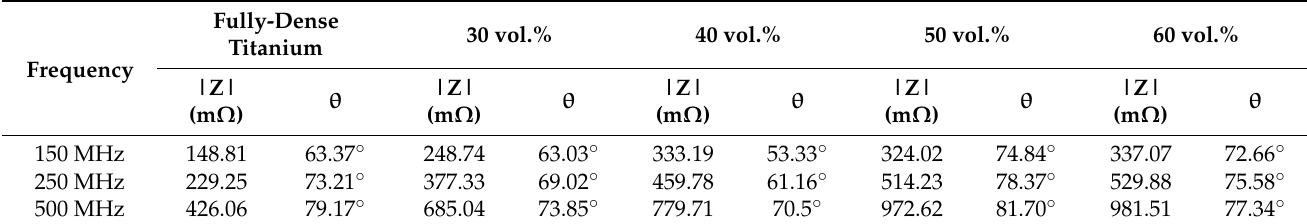
Table 2. Impedance modulus and phase values for different titanium samples with pore size 100–200 µ m after FS. Frequency